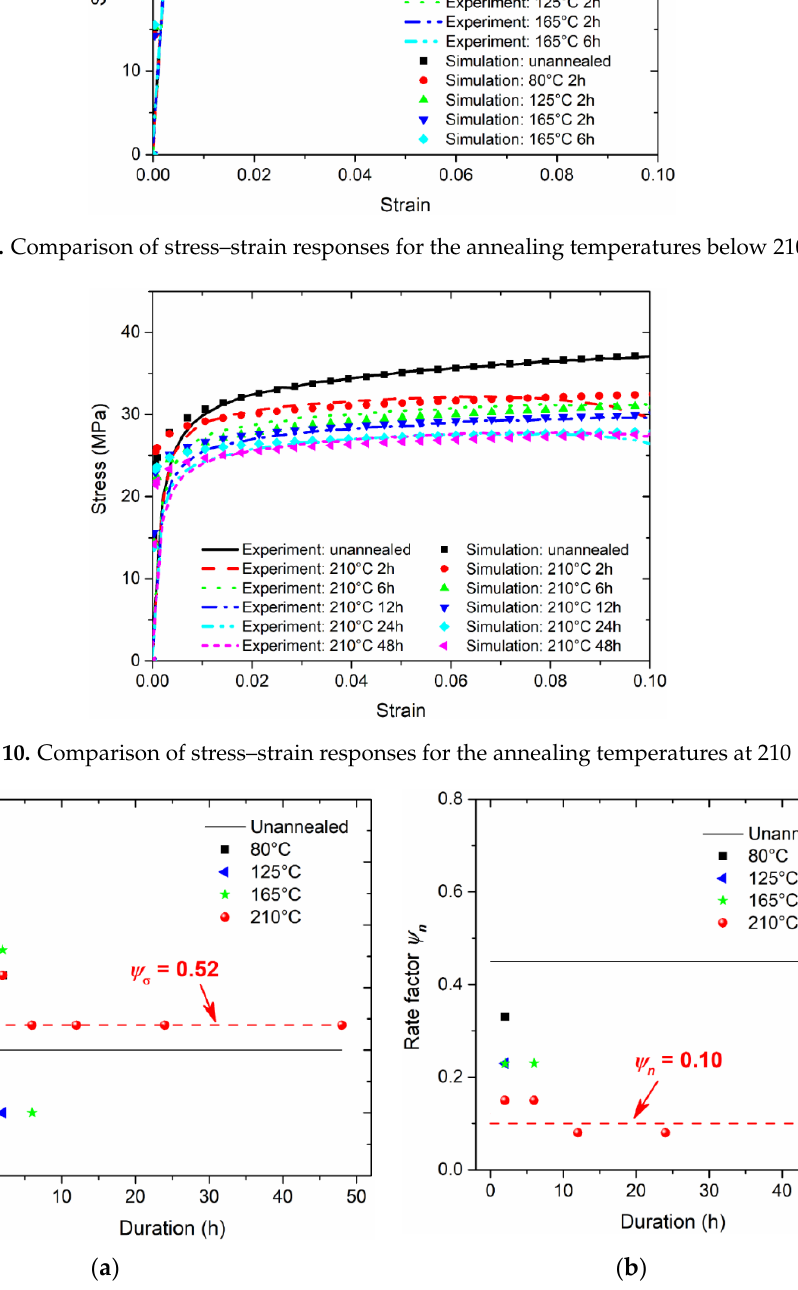
Figure 11. Rate factors for ( a ) representative stress and ( b ) the hardening exponent.